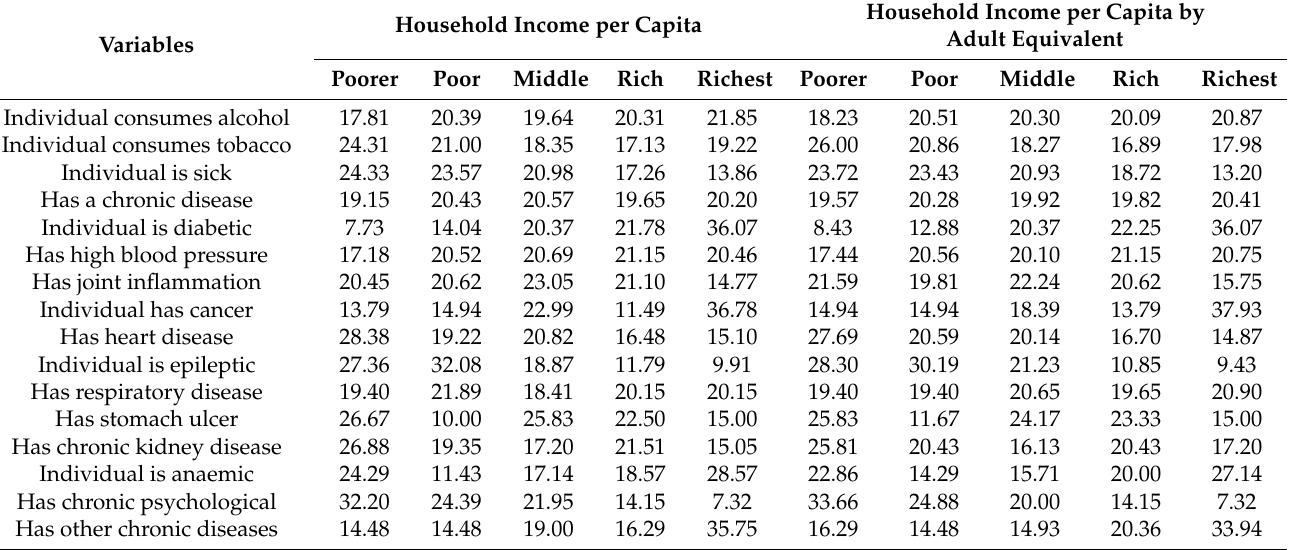
Table 2. The distribution of disease burden by household income